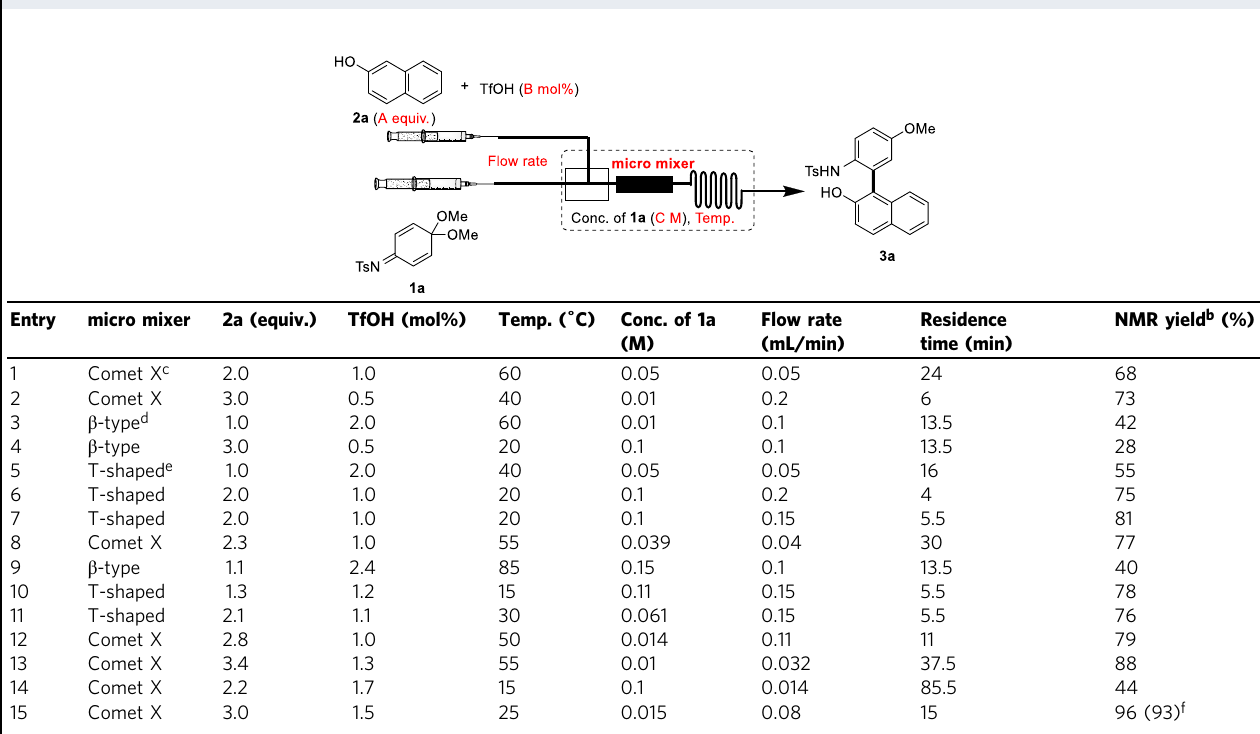
Table 1 Screening of reaction conditions for cross-coupling of IQMA 1a and 2-naphthol 2a a .